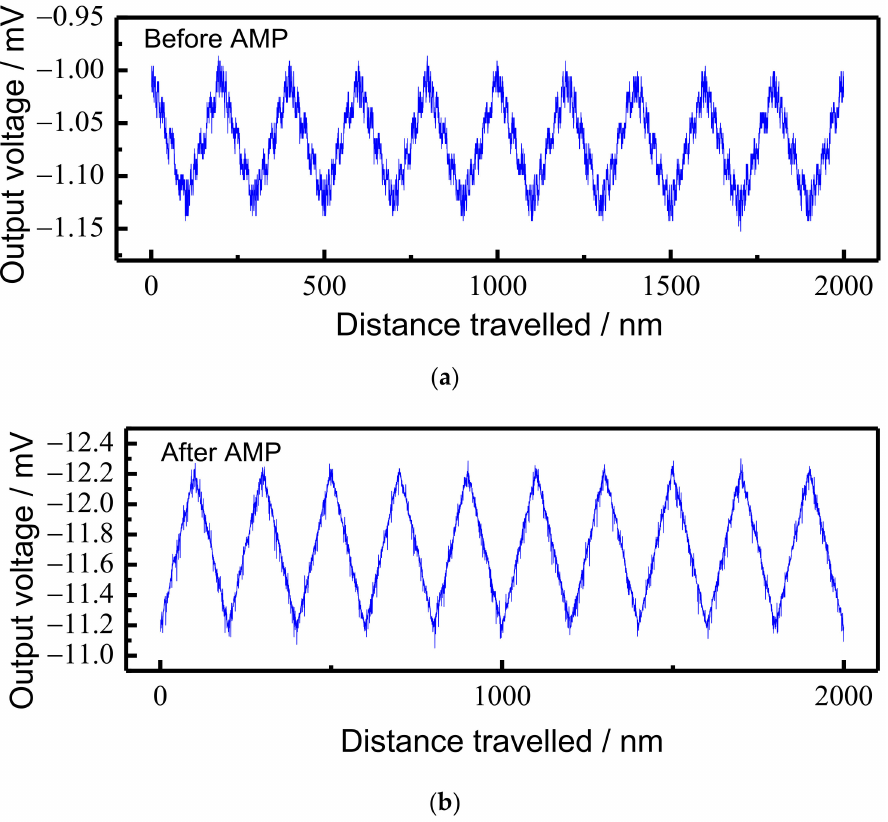
Figure 6. Calibration curve: ( a ) Before amplification; ( b ) After amplification.